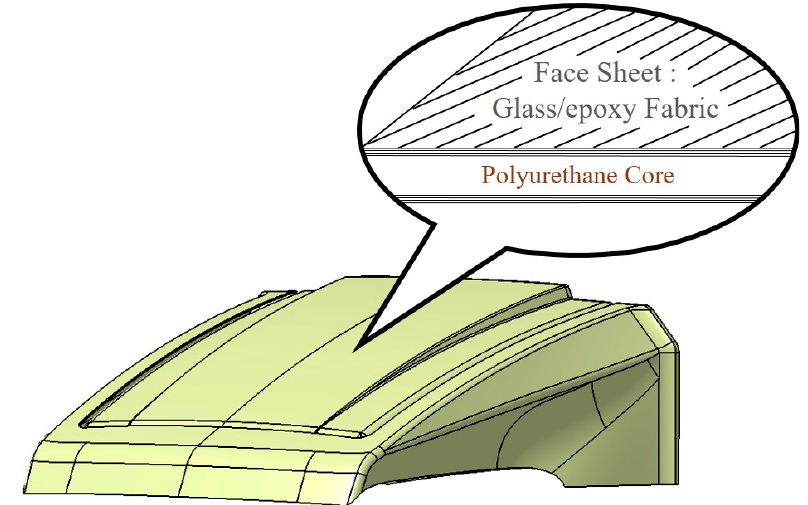
Figure 9. The shape of sandwich structures.